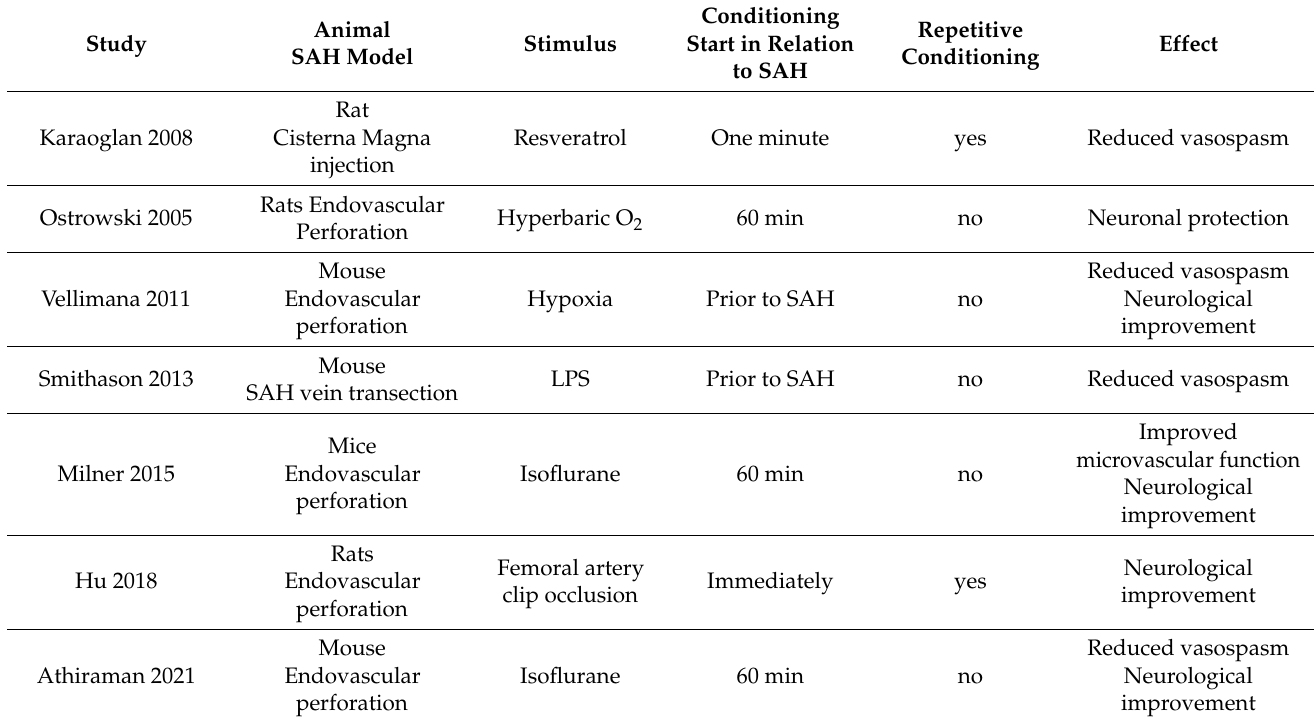
Table 2. Experimental studies of preconditioning for